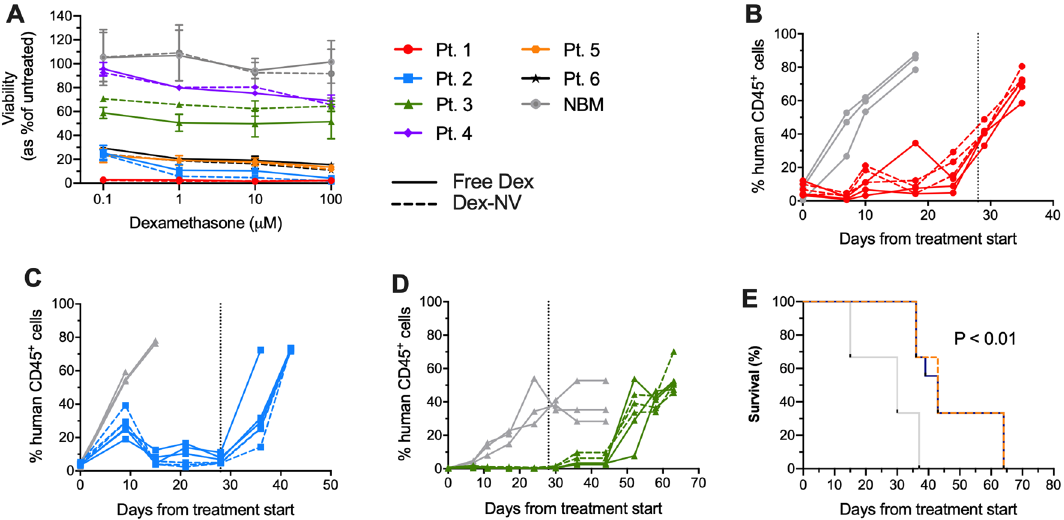
Figure 2. Efficacy of Dex-NV in vitro and in vivo. ( A ) Viability of T-ALL samples (pts. 1–6) and normal bone marrow (NBM, n = 3) treated with Dex-NV (dashed lines) or free Dex (solid lines) for 48 h. Viability was assessed by flow cytometry using Annexin-V and PI, expressed as a proportion of the untreated control sample. Data represent mean ± SD of at least 2 replicate measurements. ( B - D ) T-ALL cells from pts. 1–3, respectively, were inoculated into NSG mice and the levels of human cells (CD45 + and CD7 + ) were measured in weekly PB aspirates. Once engraftment reached > 0.1%, mice were treated IP with Dex-NV (dashed coloured line), free Dex (solid coloured line) both at 2.5 mg/kg or placebo (grey line) 5 times per week over 28 days. Engraftment levels of individual mice (n = 3 per group) are shown. Vertical dotted lines indicate end of Dex treatment. ( E ) Kaplan Meier survival analysis of ALL engrafted NSG (n = 9 per group), treated with Dex-NV (dashed line), free Dex (solid line) or placebo (grey line) IP. Survival data analysed by Log-rank test. ** P < 0.01. IP intraperitoneal, NV nanovectors, PI propidium